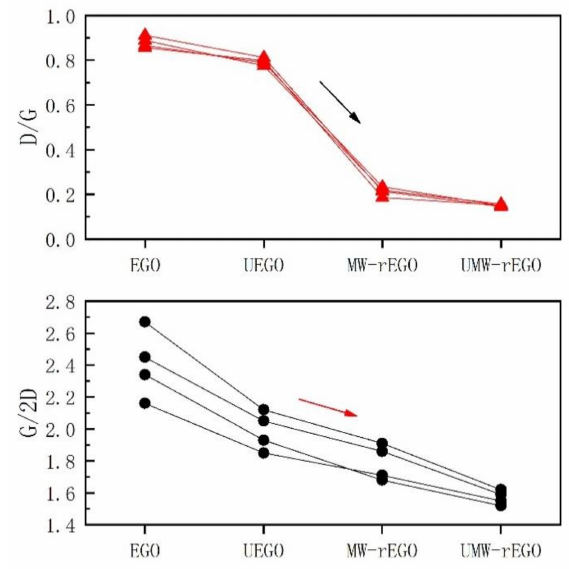
Figure 4. Raman D/G and G/2D of EGO reduced in different ways.